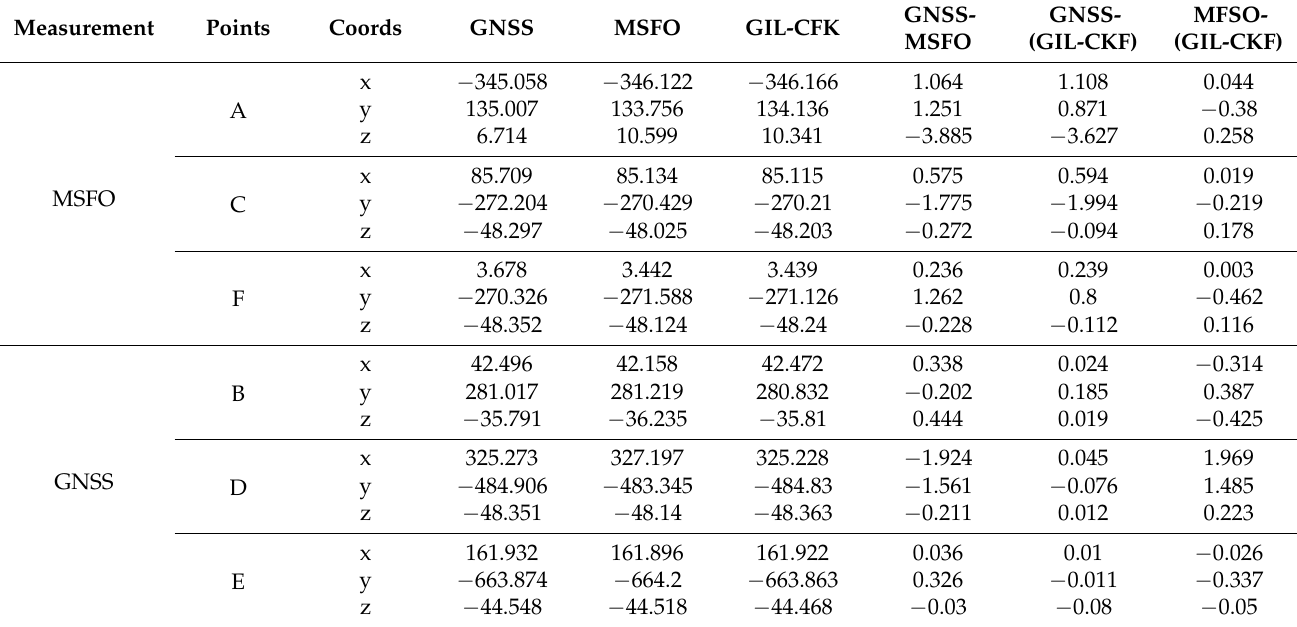
Table 3. GNSS/MSFO/GIL-CKF relative accuracy (unit: meter).